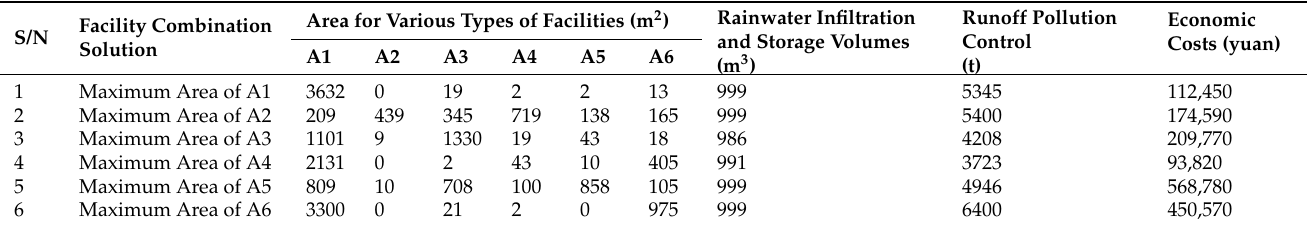
Table 9. The value of design objective for the maximum area of a particular type.